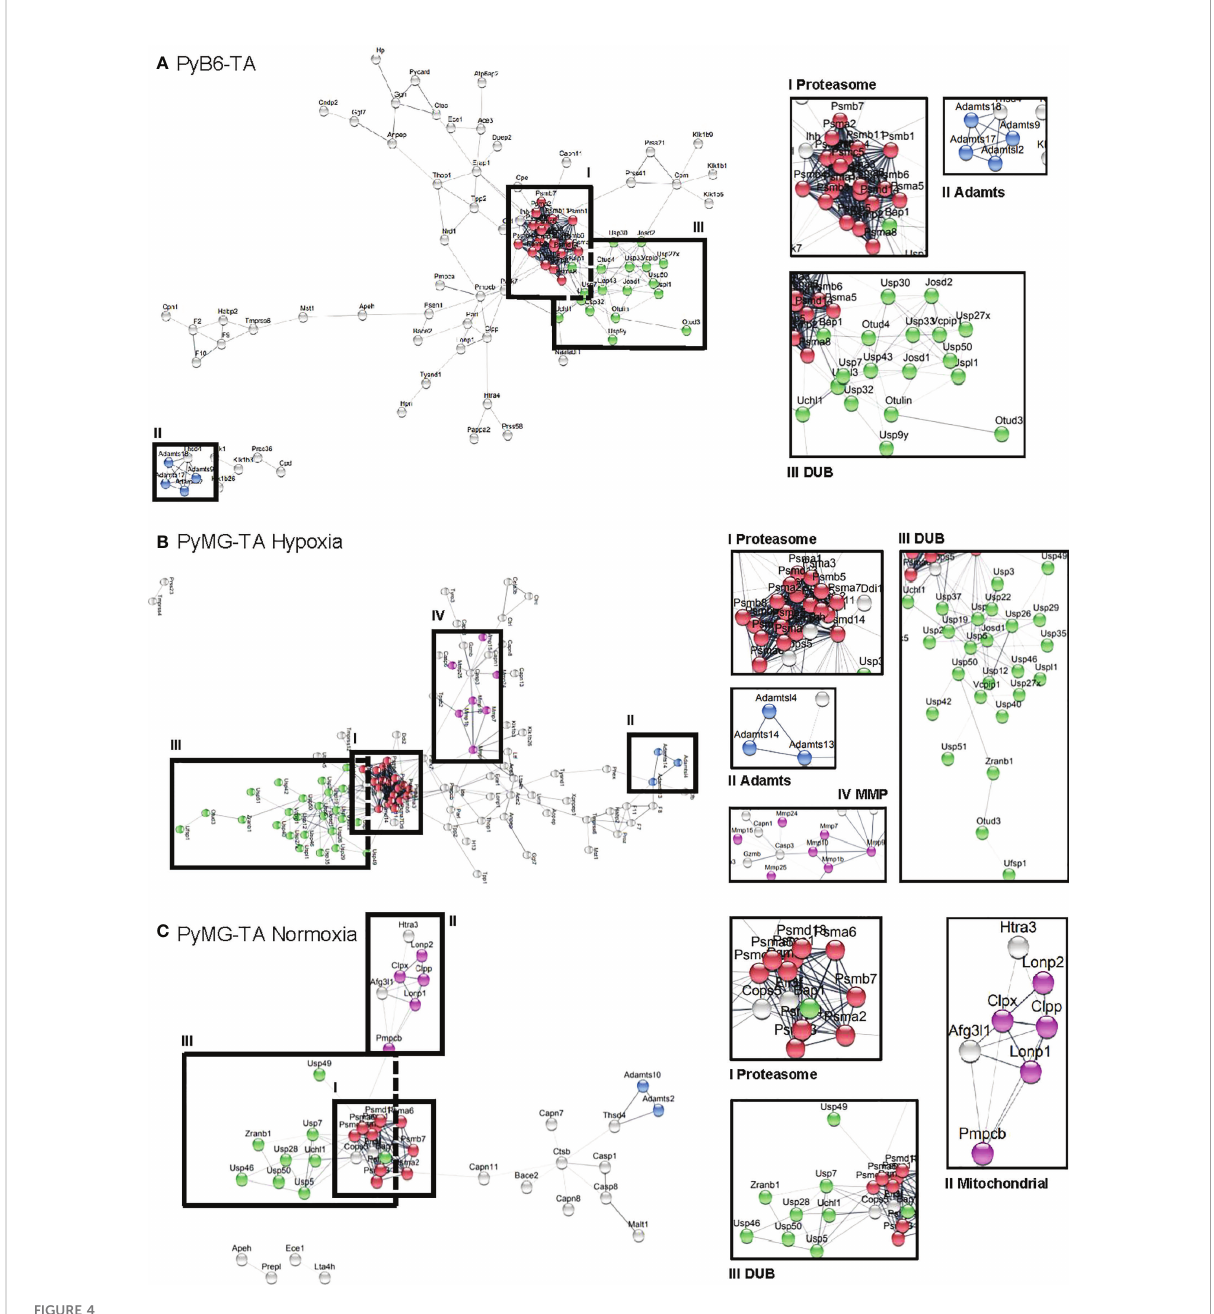
FIGURE 4 STRING-based cluster analysis. Analysis of hits from the competitive growth screens in PyB6-TA cells ( A ; 148 hits) and PyMG-TA cells cultured under hypoxic conditions ( B ; 138 hits) or normoxic conditions ( C ; 63 hits). Hits selected based on fi rst selection criteria ( ≥ 2 miR-Es outside ±1 SD_AvSSMD*). Interesting clusters magni fi ed on the right; associated proteins in color. Red: proteasomal subunits; Green: DUBs; Blue: Adamts; Pink: MMPs (B) or mitochondrial proteases (C)